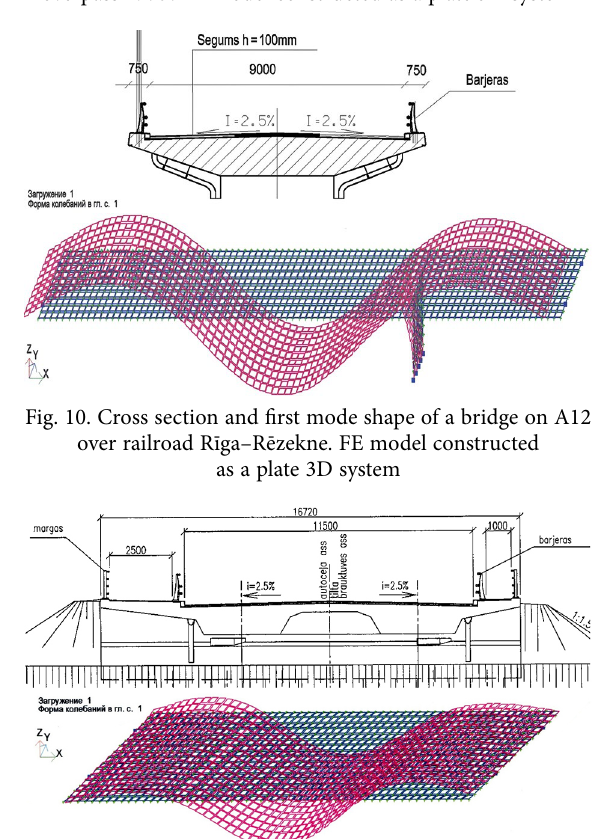
Fig. 9. Cross section and first mode shape of a South bridge overpass Nr. 7. FE model constructed as a plate 3D system